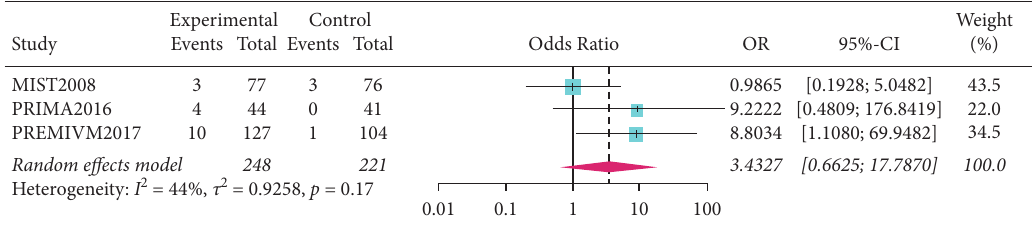
Figure 3: Forest plot for complete resolution of migraine headache.